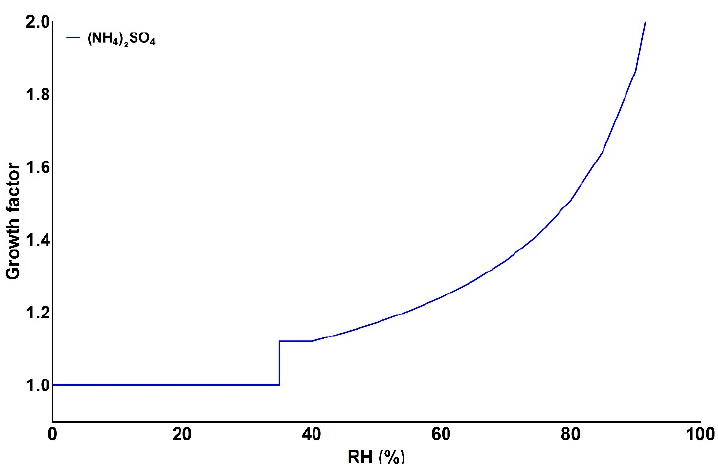
Figure 5. Growth factor curve as function of relative humidity (RH) for ammonium sulphate. The discontinuity represents the efflorescence point of the compound [27].